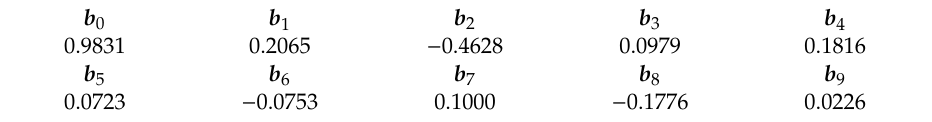
using the train data and the RSM 2